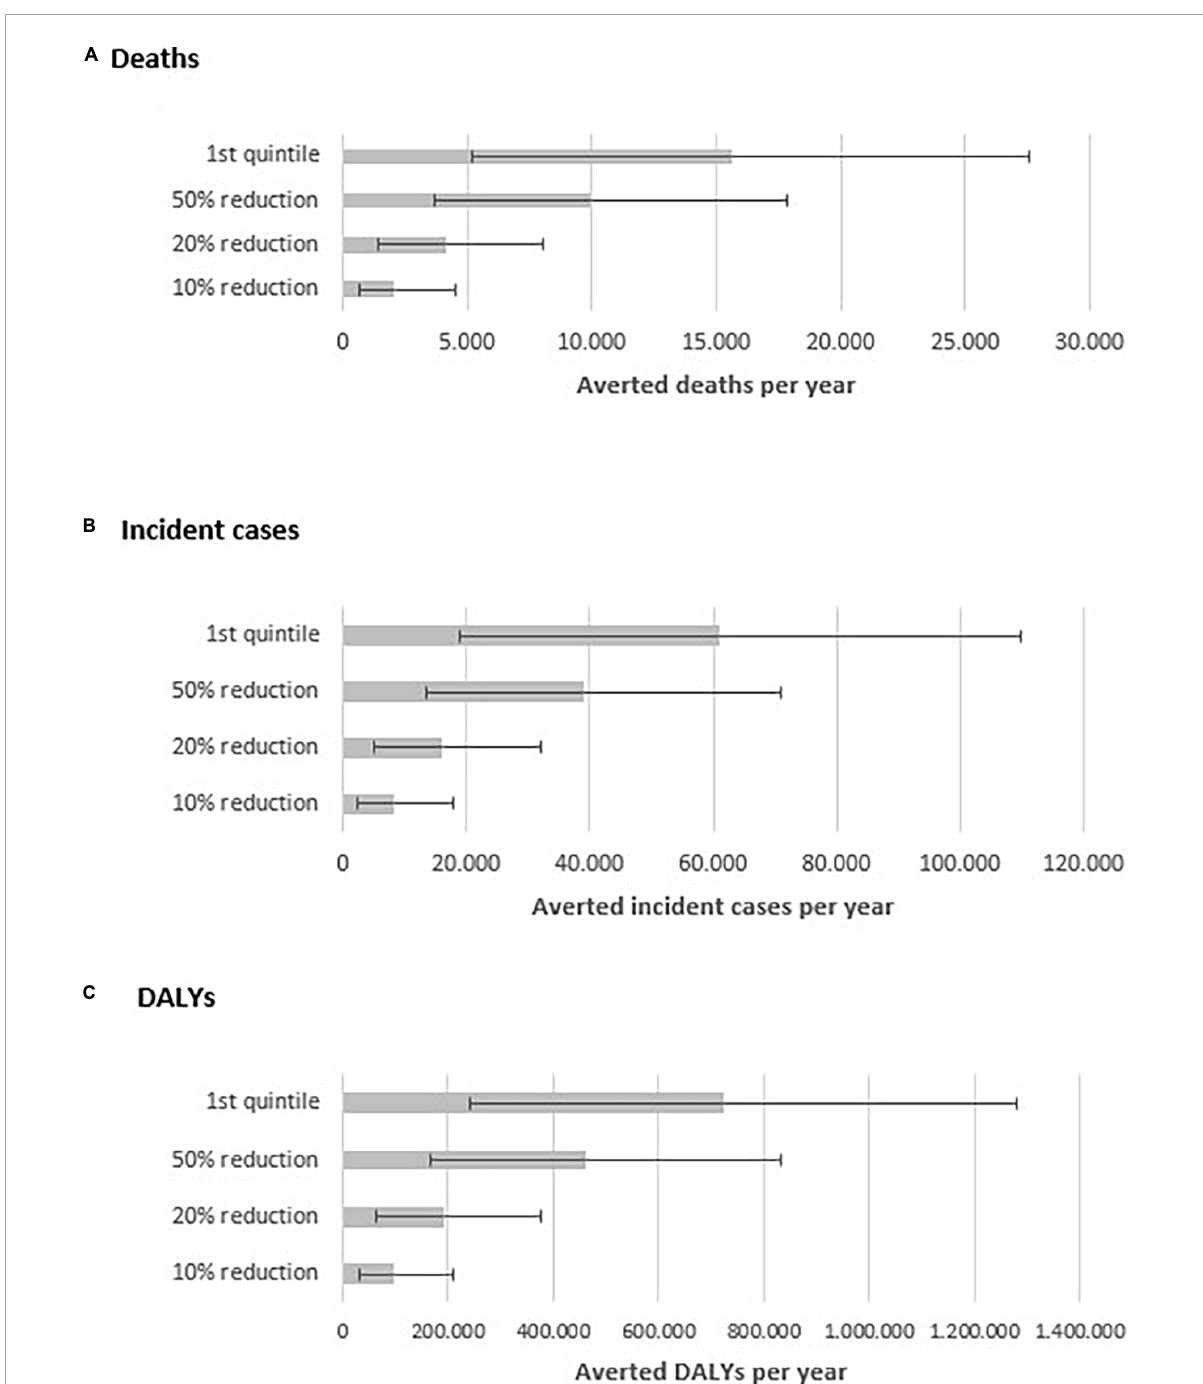
FIGURE1 Estimated number of averted premature deaths (A) incident cases (B) and DALYs (C) per year by scenario of reduction of ultra-processed food intake in Brazil.